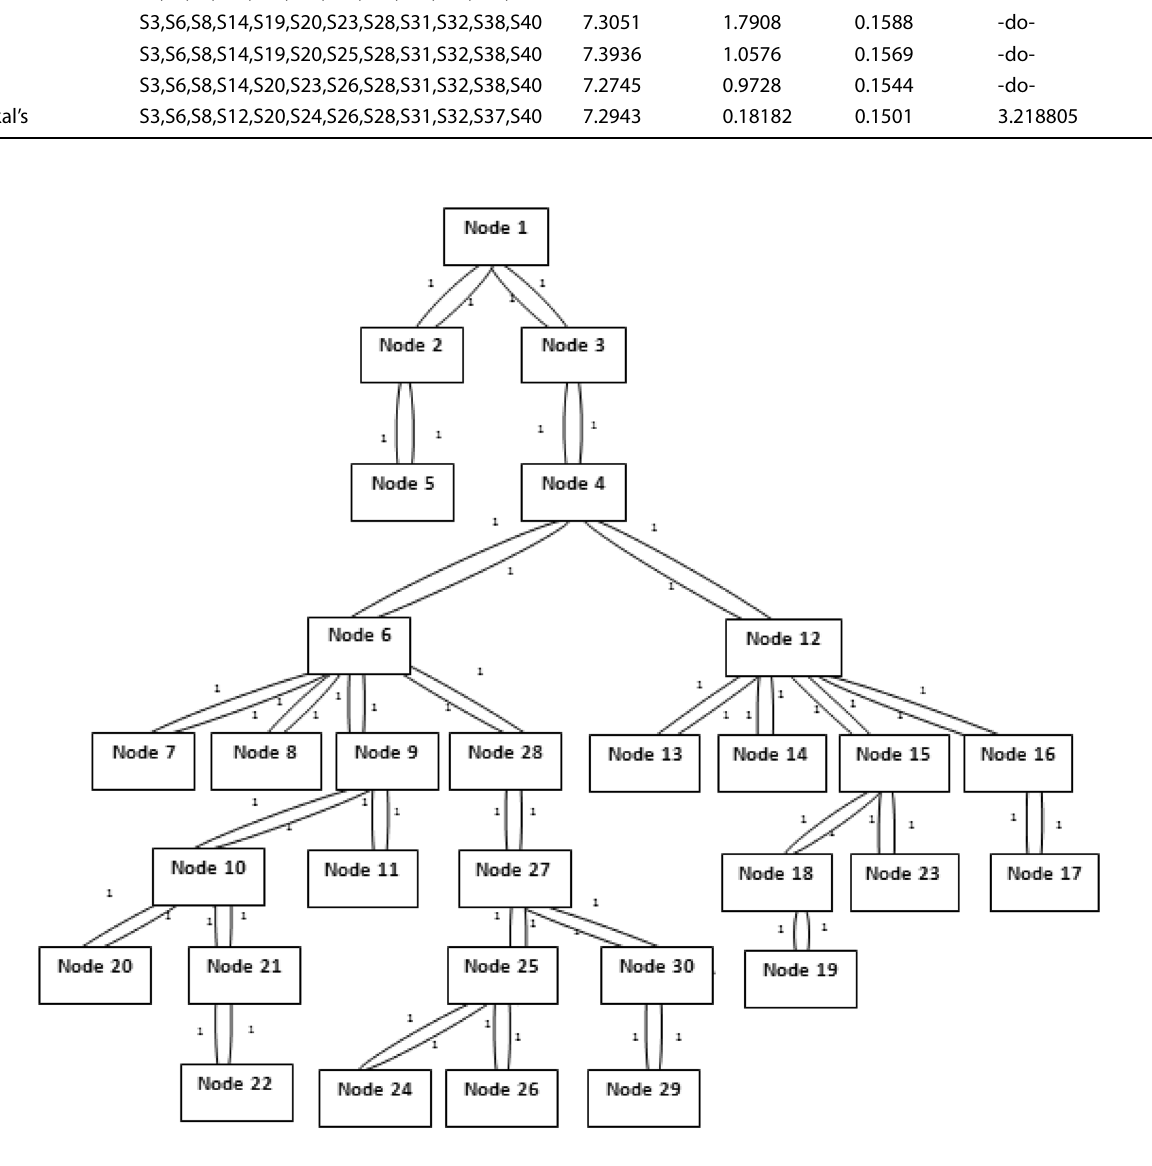
Fig. 8 Optimal radial network obtained by applying Kruskal’s algorithm for the cases with 80%, 70%, 60% and 59% of base-load